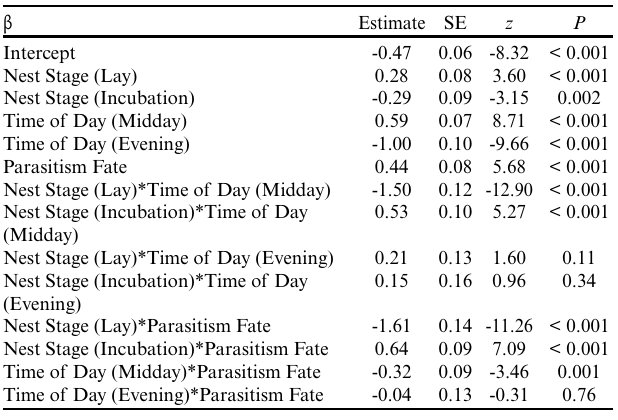
Table 6. Parameter estimates for the best model assessing the predator-attraction hypothesis and the relationship between vocalization rate by male vireos and nest stage (Stage), time of day (Time), and parasitism fate (Para)